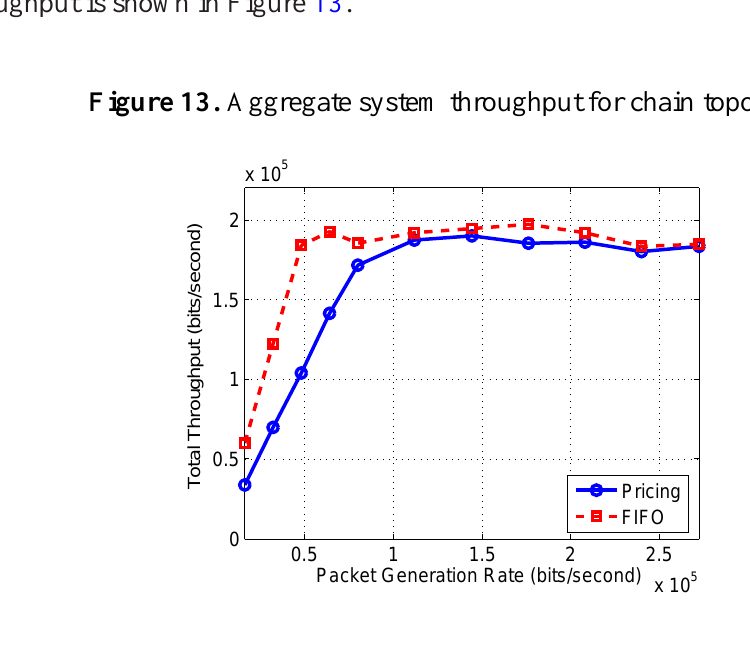
Figure 14. Pi values of different types of Event packets for chain